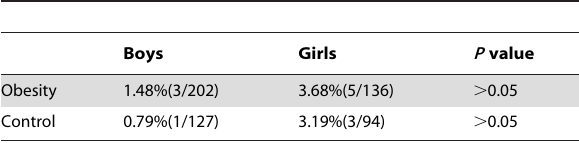
Table 5. Prevalence of FTO and SH2B1 rare non-synonymous mutations in different populations.